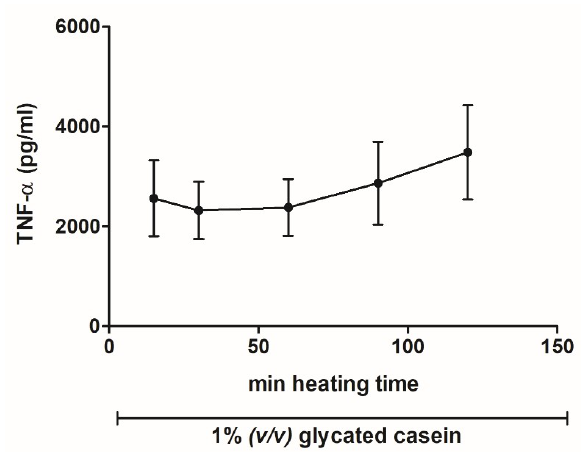
Figure 5. TNF- α secretion of human macrophage-like cells after 6 h exposure to 1% ( v/v ) glycated casein from different heating time points measured by ELISA. Data are presented as mean ± SD, n = 4.